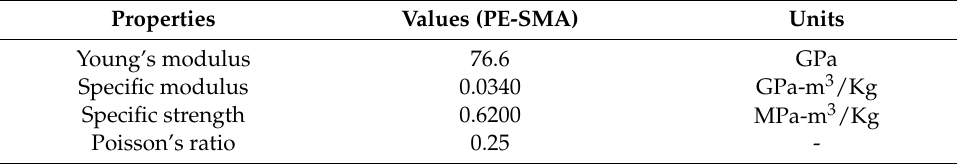
Table 2. Material properties of glass fibers.